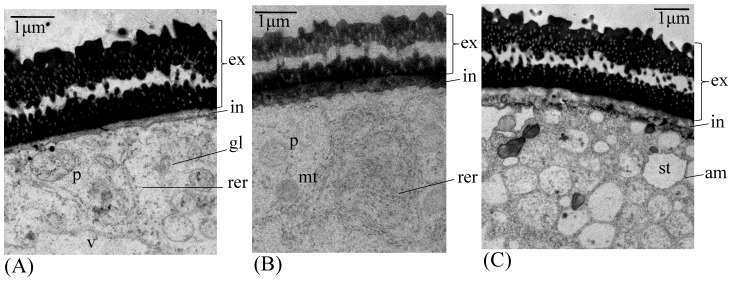
Electron micrographs of wheat microspores after pretreatment using transmission electron microscopy.Figures a-c show differences in thickness of intine, number of cytoplasmic organelles and amount of starch accumulated in amyloplasts. (A) represents type I developmental pathway, (B) represents type II developmental pathway, and (C) represents type III developmental pathway. am =  amyloplast, ex =  exine wall, in =  intine layer, mt =  mitochondria, gl =  Golgi apparatus, p =  proplastid, rer =  rough endoplasmic reticulum, st =  starch.